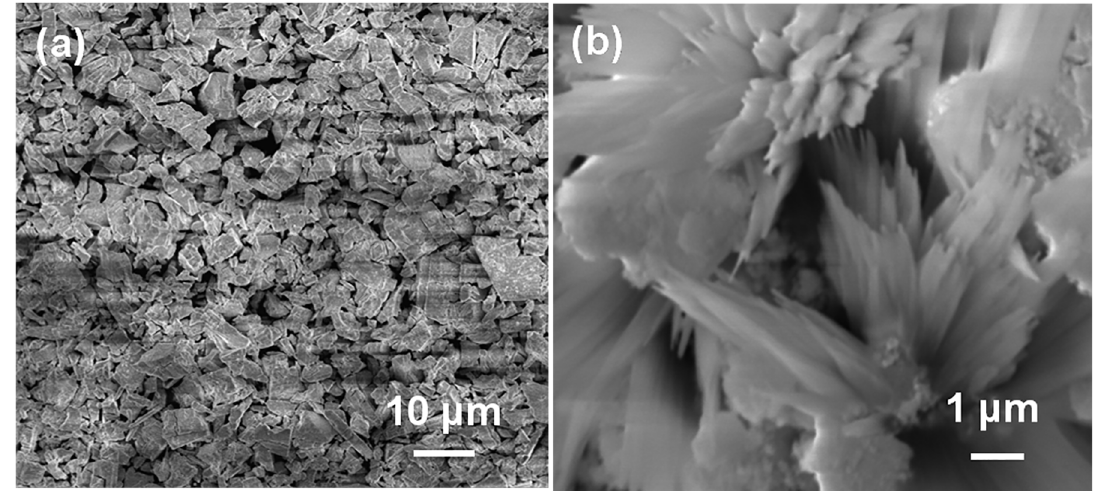
raw materials; (b) 1% Mn/CeO 2